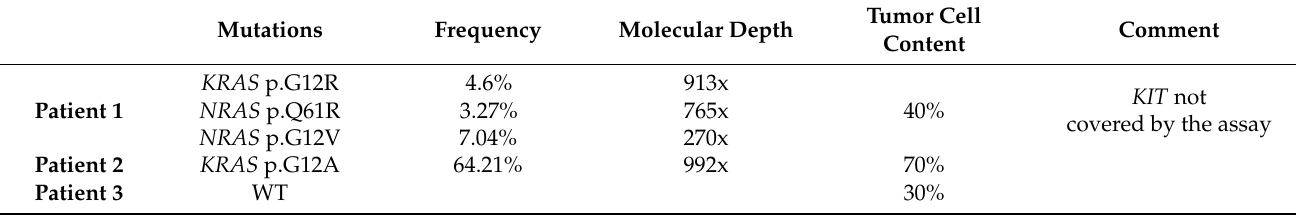
Table 1. High sensitivity NGS analysis of whole tumor sections before